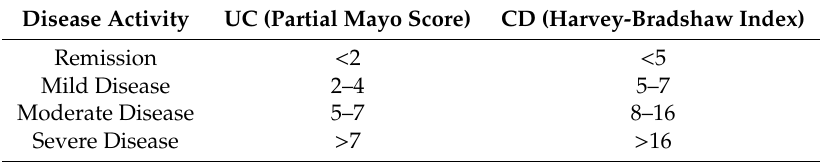
Table 1. Mayo Score and Harvey–Bradshaw index